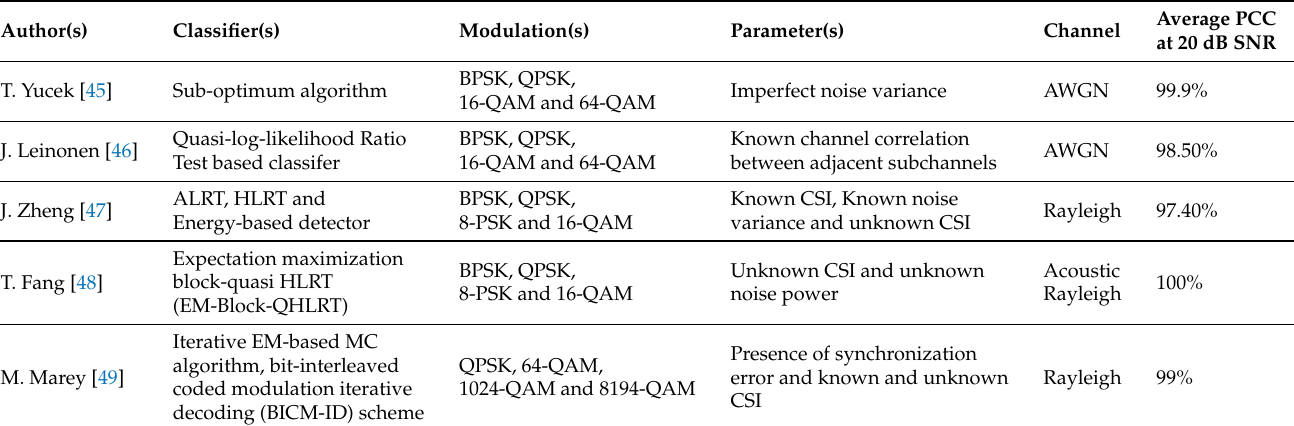
Table 2. Summary of LB approaches for OFDM